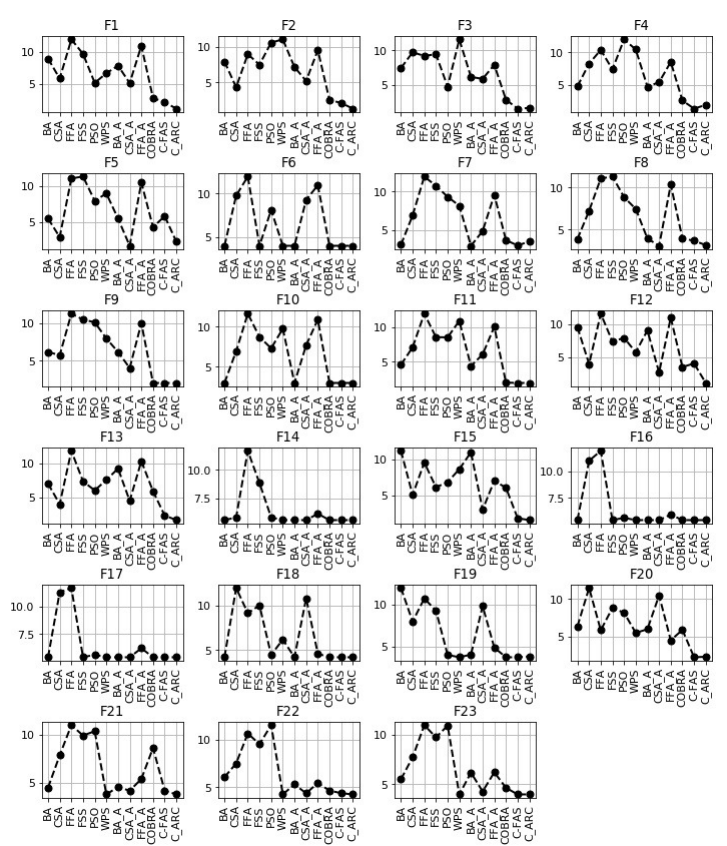
Figure 3. Results of the Friedman statistical test for